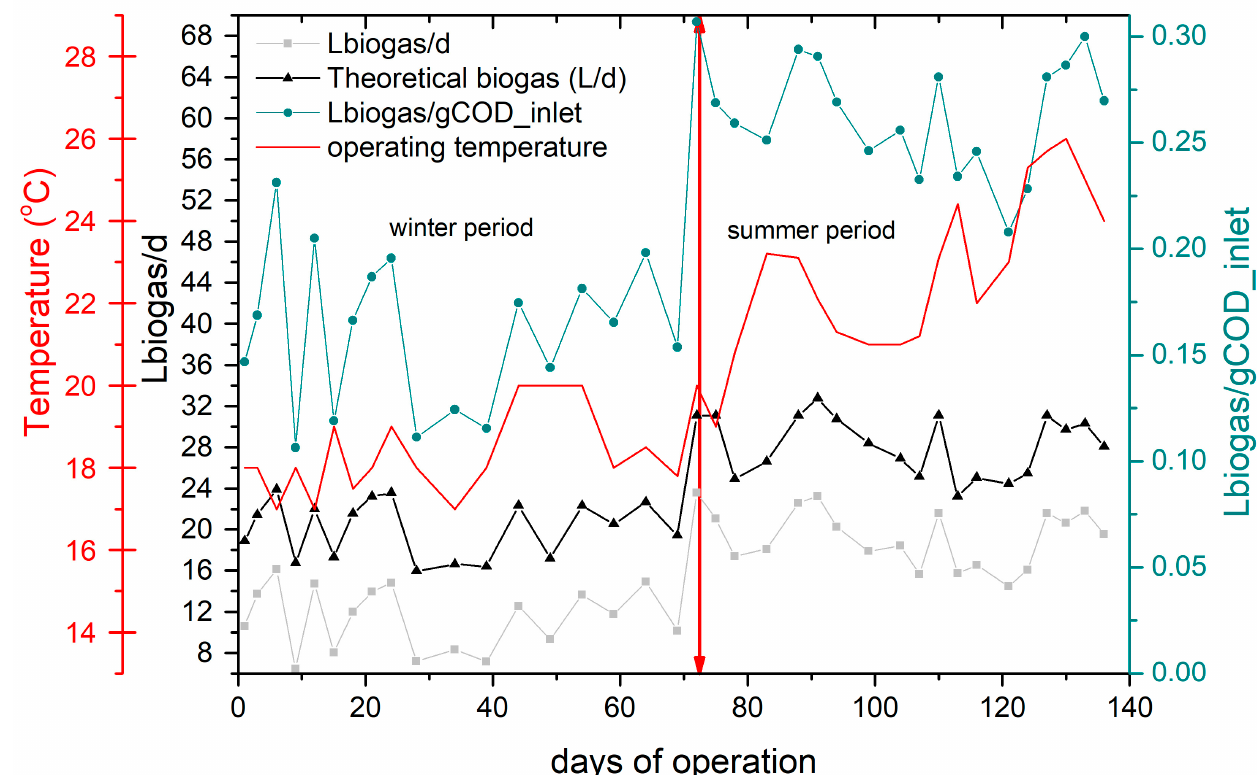
Figure 3. Biogas production pro fi le during AnMBR operation at 6 h HRT.